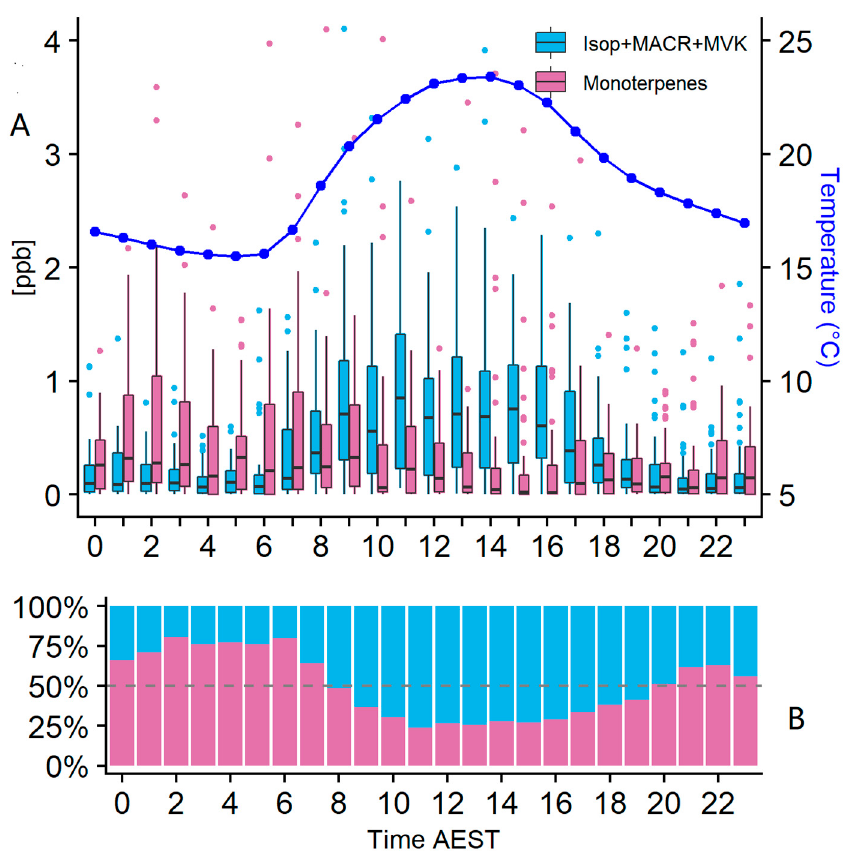
Figure 9. ( A ) Composite mean concentration of monoterpenes and isoprene grouped by hour between February and May. On the right y-axis is the average temperature for the analysed period. June data were excluded to capture a better representation of the influence of temperature on VOC concentrations. The black line represents the median, the line on the box is the 95% of the distribution range and outliers are shown as blue and pink. The calculated PAR from the solar radiation observations has a correlation coefficient with temperature of 0.62, and both parameters follow a similar daily pattern influencing the VOC emissions (see Supplementary Figure S8). ( B ) Percentage contribution of BVOC groups to total BVOC loading per hour using mean concentrations.